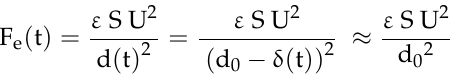
In Equation (1), the permittivity of the gel is ( ε ) and the surface area of the capacitor plates (foil or metal mesh) is (S). The instant distance between the plates is (d) and may be expressed in terms of the initial plate distance (d 0 ) and displacement ( δ ). The initial thickness of the gel is 1 mm (d 0 = 1 mm) and the surface area of the stainless-steel mesh is 177 mm 2 (S = 177 mm 2 ). Notice that in Equation (1), small displacements compared to the initial plate distance are assumed small ( δ (cid:28) d 0 ), which yields ( d 0 − δ ) ≈ d 0 . The viscoelastic creep of the gel under the action of the constant mechanical force (F m ) and a stepwise constant potential (U) may be expressed as in Equations (2) and (3), respectively. Furthermore, notice that the expressions in Equations (2) and (3) are rewritten in terms of the parameters c 1 = d 0 /S and c 2 = ε / ( d 0 ) = ( ε 0 ε r ) / ( d 0 ) where the permittivity of vacuum is ( ε 0 ) and the relative permittivity or the dielectric constant is denoted ( ε r ). The dielectric constant is in this work set to ( ε r = 3000) but may